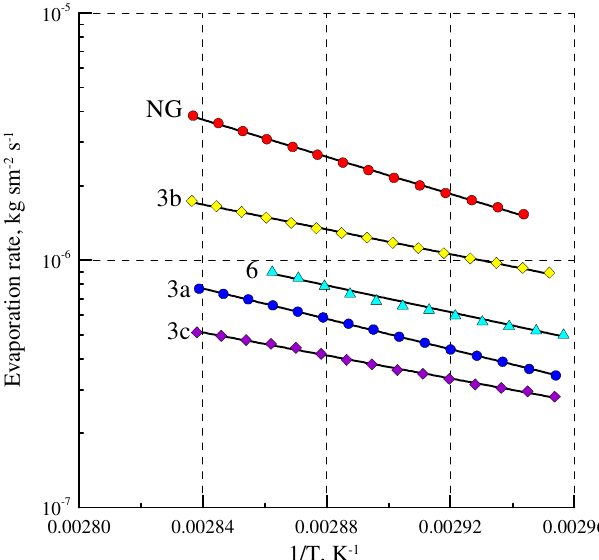
Figure 3. Evaporation rates of azides 3a , 3b , 3c and 6 in comparison with NG , depending on temperature.